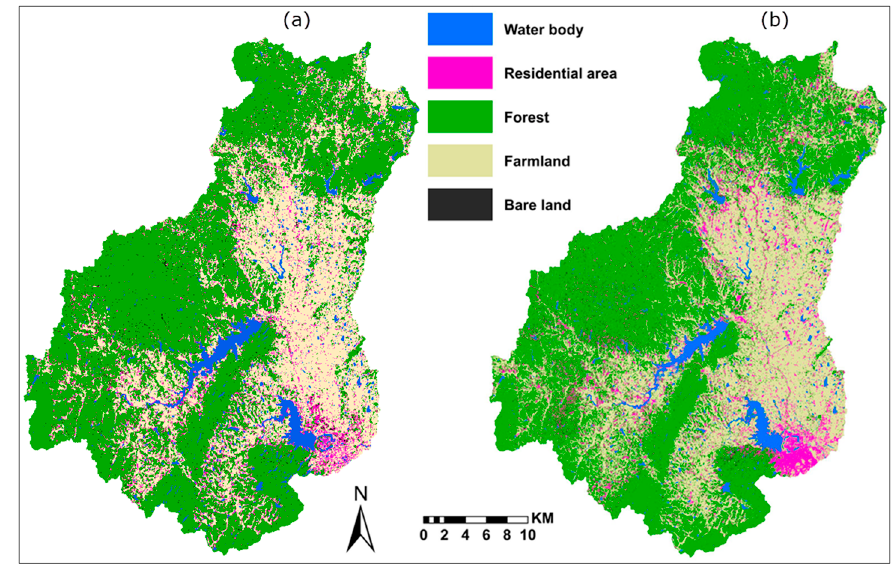
Figure 6. Land-use classification results in 1981 ( a ) and 2000 ( b ) for the Qinliu River basin, East 323